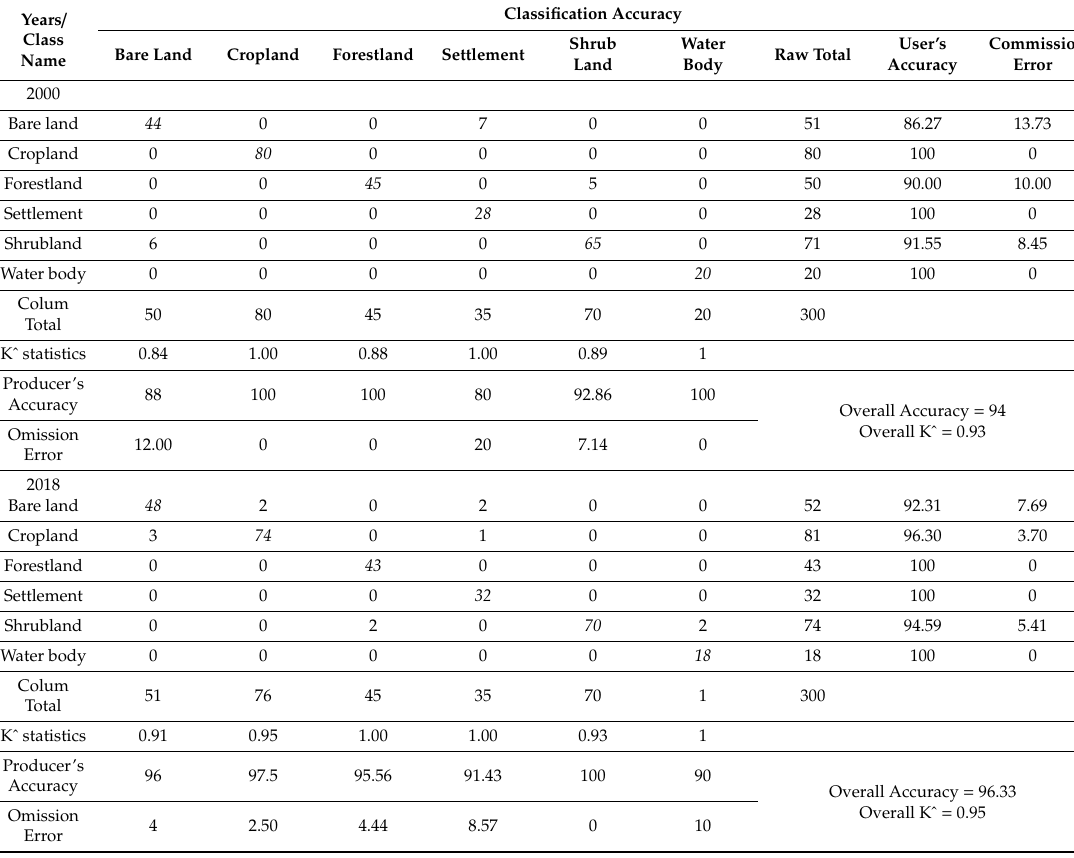
Table 3. Accuracy statistics for the classified LULC maps in percent.